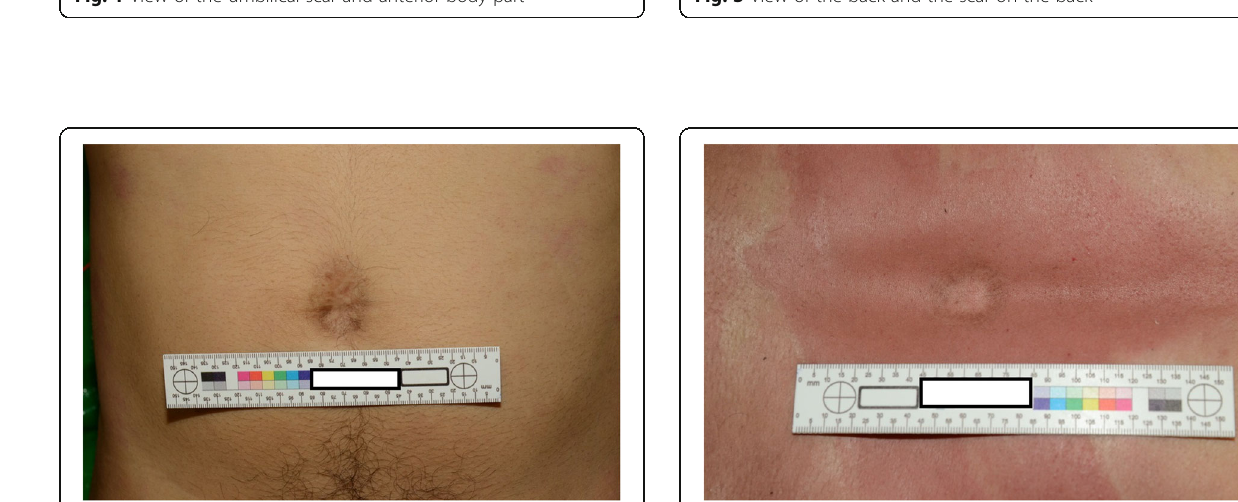
Fig. 1 View of the umbilical scar and anterior body part